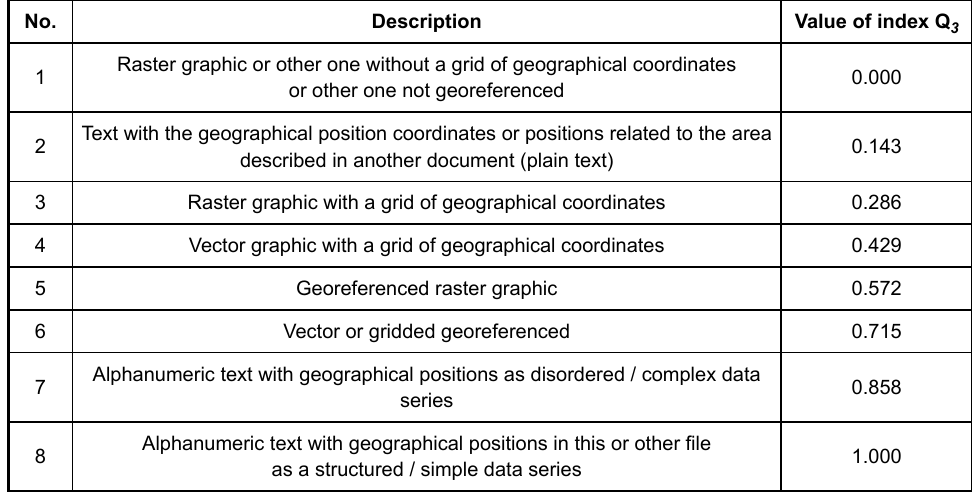
Table 3. File type index Q 3